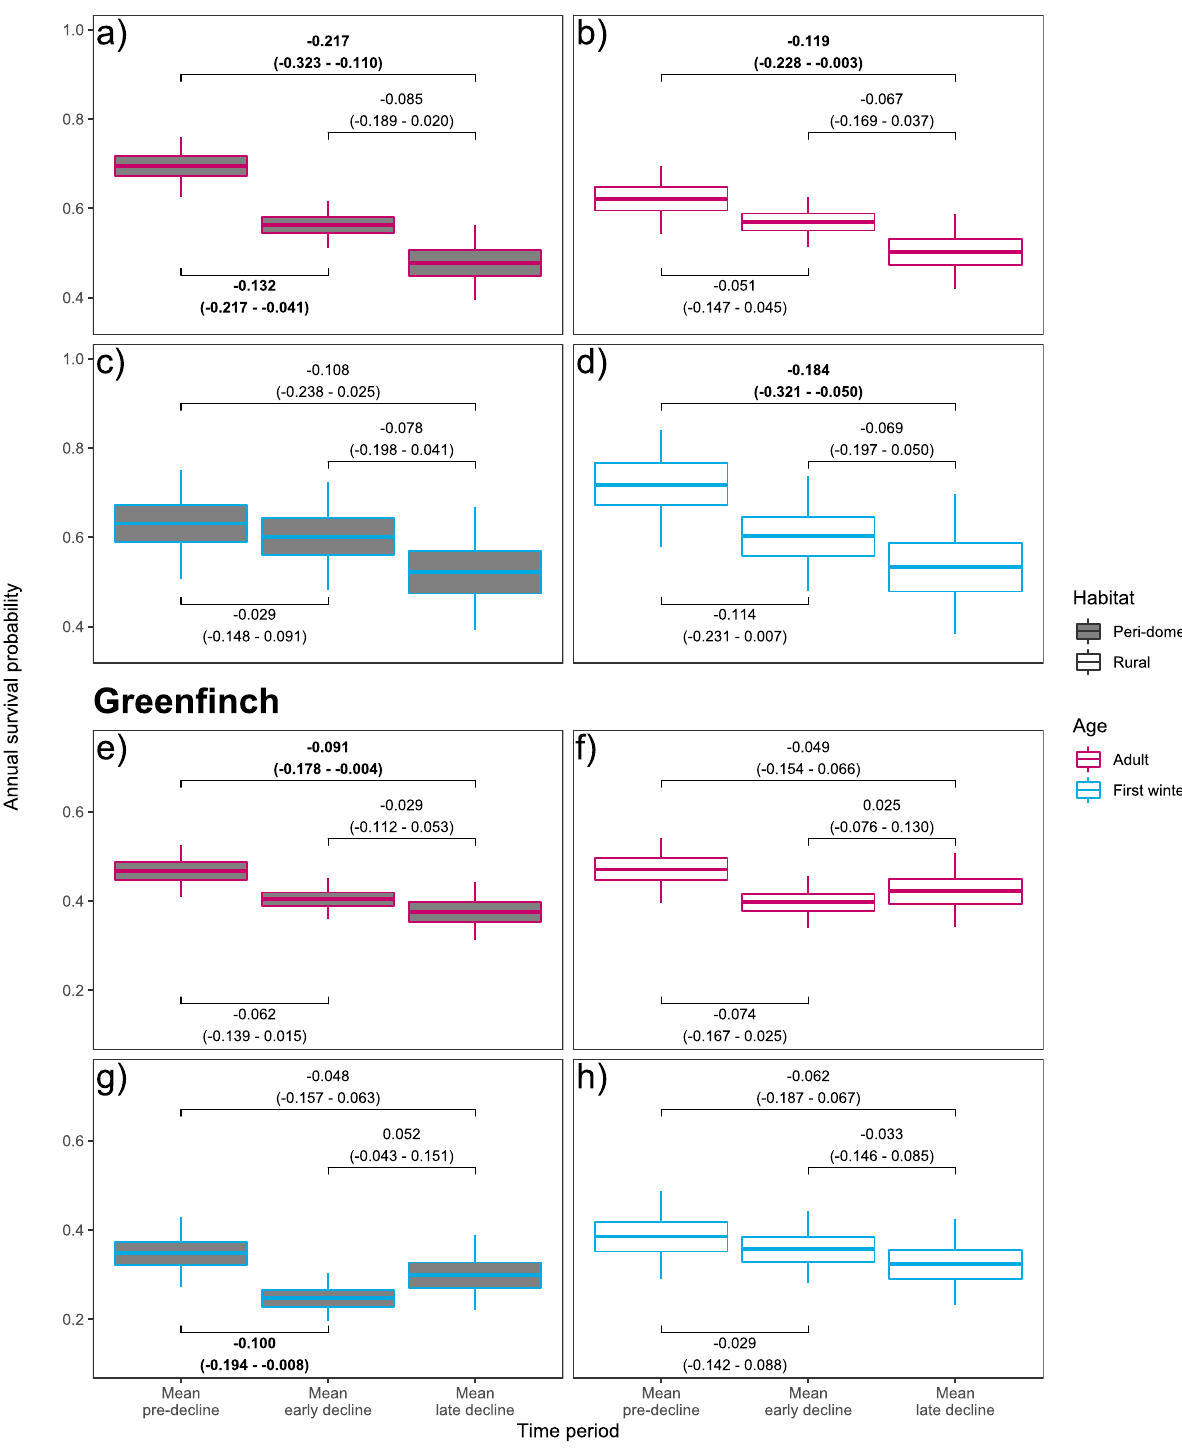
Figure 4. Mean habitat-specific annual survival estimates for ( a – d ) chaffinch and ( e – h ) greenfinch between 2000 and 2018, with mean survival blocks for the pre-decline (2000–2005), early decline (2006–2012) and late decline (2013–2018) periods, from the respective habitat-specific mark-recapture models. In the plots, bars show the mean, boxes the 50% and whiskers the 95% credible intervals (CI) calculated via posterior density intervals. In the labels the top lines show the mean change in mean survival between the relevant block periods and the second line is the 95% CI for the change in survival. Labels where the 95% CI did not overlap zero are displayed in bold. The recovery reporting probabilities were species, age- and